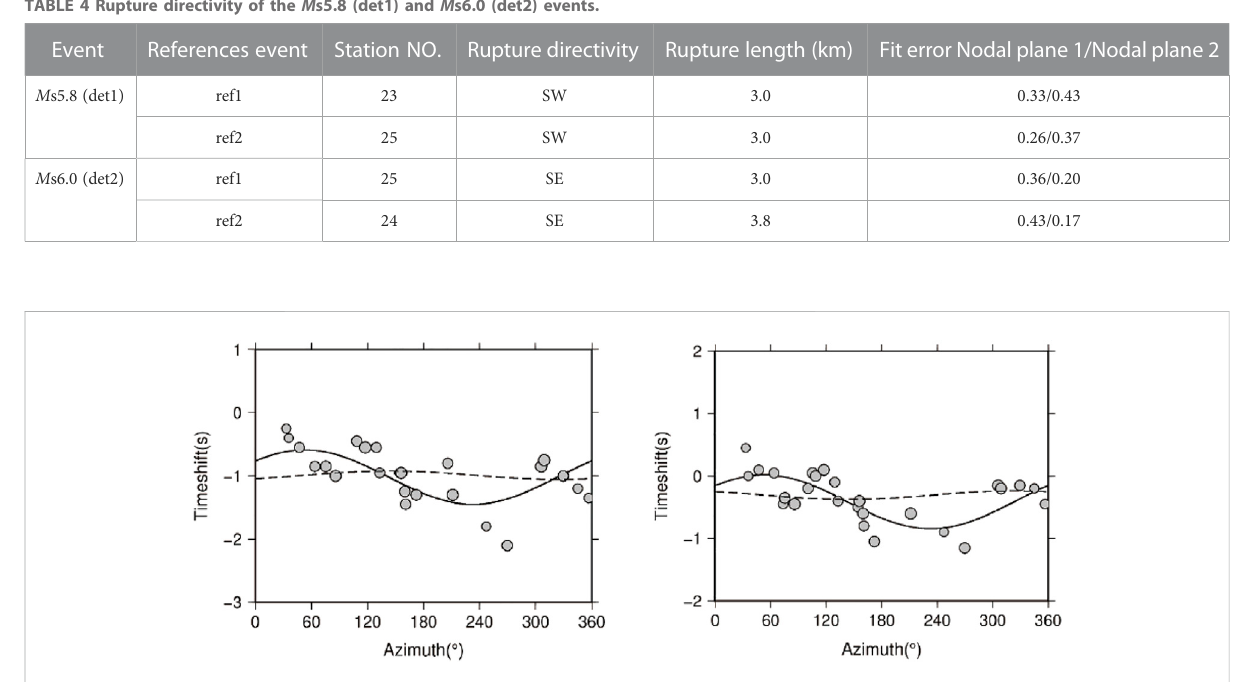
FIGURE 14 Rupture directivity fi tting of the M s5.8 event (det1). Two reference events are used (left: ref1; and right: ref2). Dots denote the time shift differences at each station (CC ≥ 0.9), and the lines denote the predicted time shifts of nodal planes 1 (solid) and 2 (dashed) listed in Table 3. The results indicate ~3 km of rupture to the southwest.